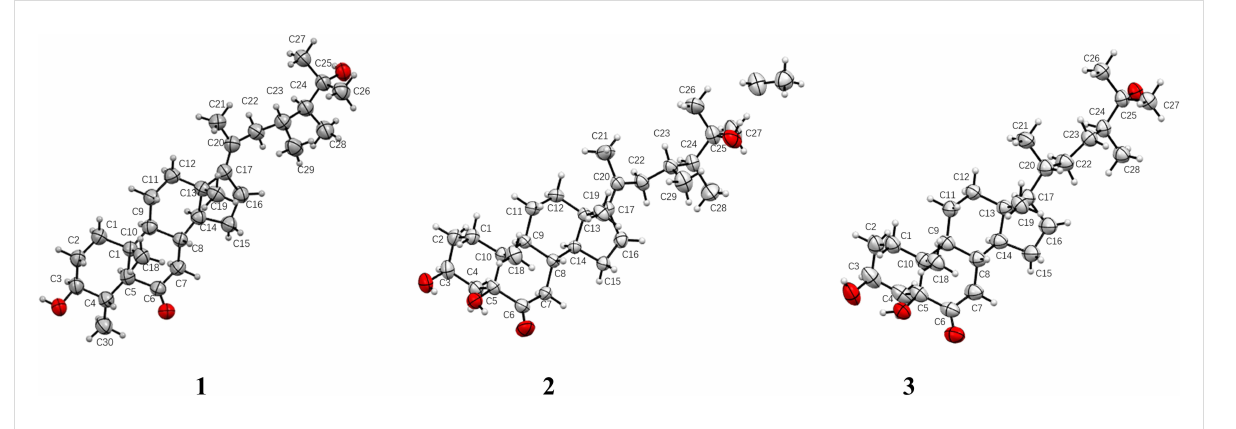
Figure 4: X-ray crystallographic analysis of compounds 1 – 3